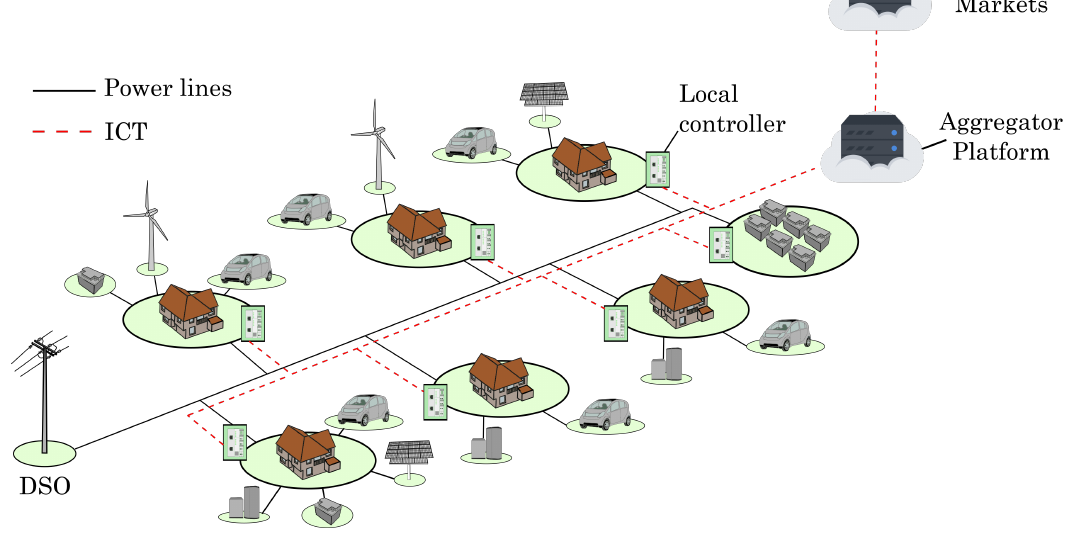
Figure 3. Local energy community example connected to the aggregator